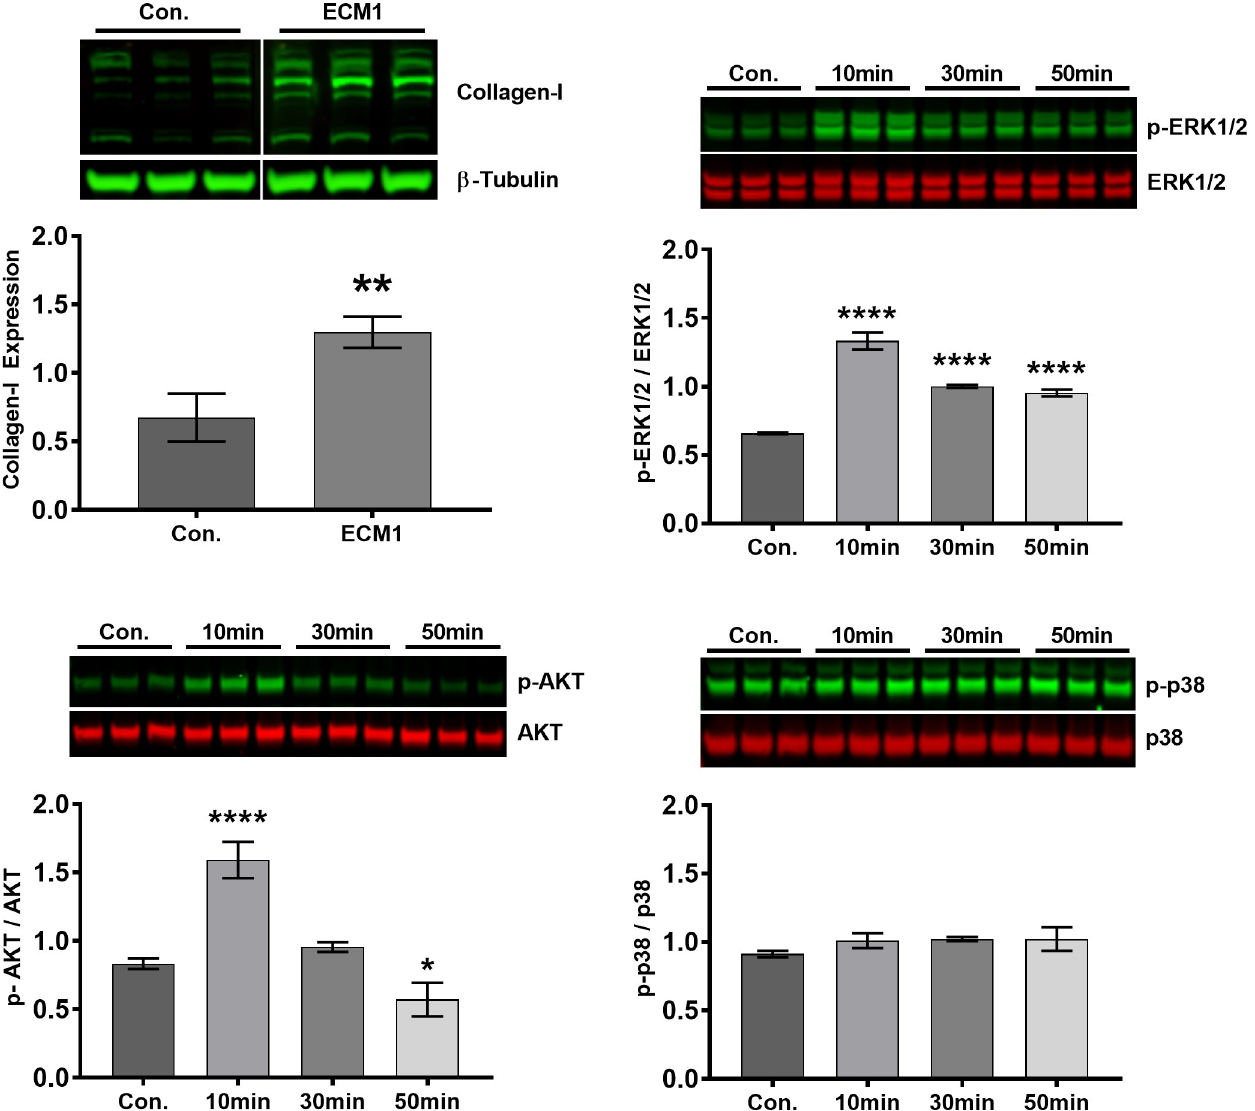
Fig 4. ECM1 stimulates collagen-I expression and ERK1/2 and AKT pathway activation in cardiac fibroblasts. Collagen-I protein expression was increased in human CFbs in response to 48 h of treatment with recombinant ECM1 (20ng/ml) relative to untreated control (Con.) cells (top left); data normalized to β -tubulin expression (~55kDa). Immunoblots of ERK1/2 and p-ERK1/2 at Thr202/Tyr204 (top right), AKT and p-AKT at Ser473 (bottom left), and p38 and p-p38 at Thr180/Tyr182 (bottom right) expression in human CFbs treated with recombinant ECM1 (20ng/ml) for 10, 30 or 50 minutes. Shows significant ERK1/2 activation at 10, 30 and 50min, and AKT activation at 10min. Data is represented as phosphorylated/non-phosphorylated protein. The blot image in top left figure was cropped only to re-arrange the order of control lanes of the same blot. All data is expressed as mean ± SD, with n = 3 technical replicates/group. � p < 0.05, �� p < 0.01, ���� P < 0.0001 relative to control.